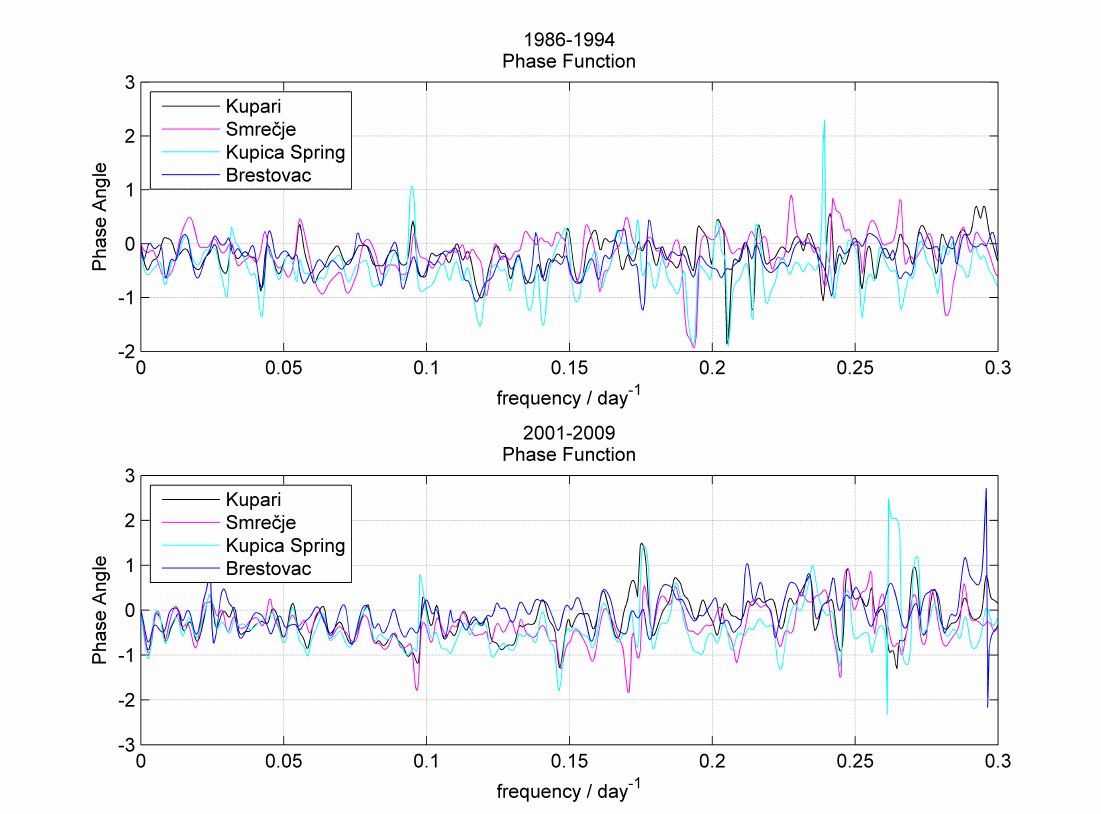
Figure 9. The phase function obtained for the studied hydrological and meteorological stations for the two analyzed